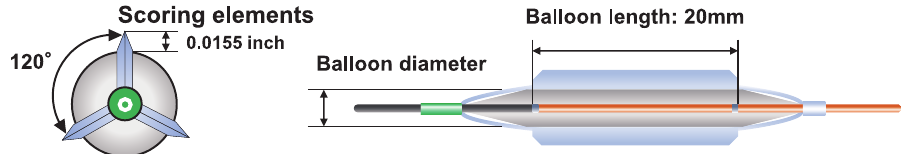
Fig 1. Non-slip element percutaneous transluminal angioplasty balloon (NSE PTA). The NSE PTA scoring balloon is a non-slip peripheral angioplasty catheter with three nylon scoring elements for a controlled scoring of the vessel wall and aimed to reduce slipping during balloon